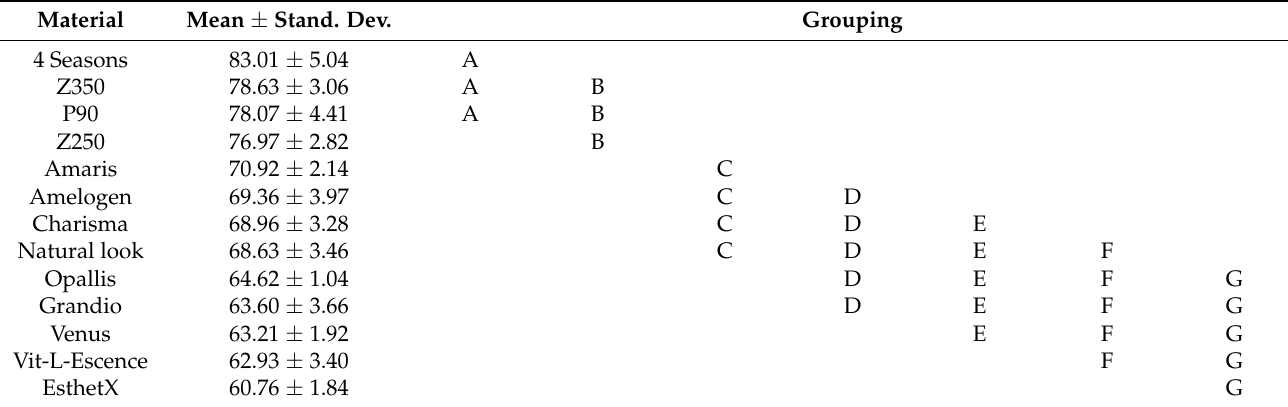
Table 7. Mean and standard deviation for the degree of conversion measurement according to the factor resin composite material. Same Capital Letter(s) means no statistical difference among groups ( α = 0.05). Material Mean ± Stand.